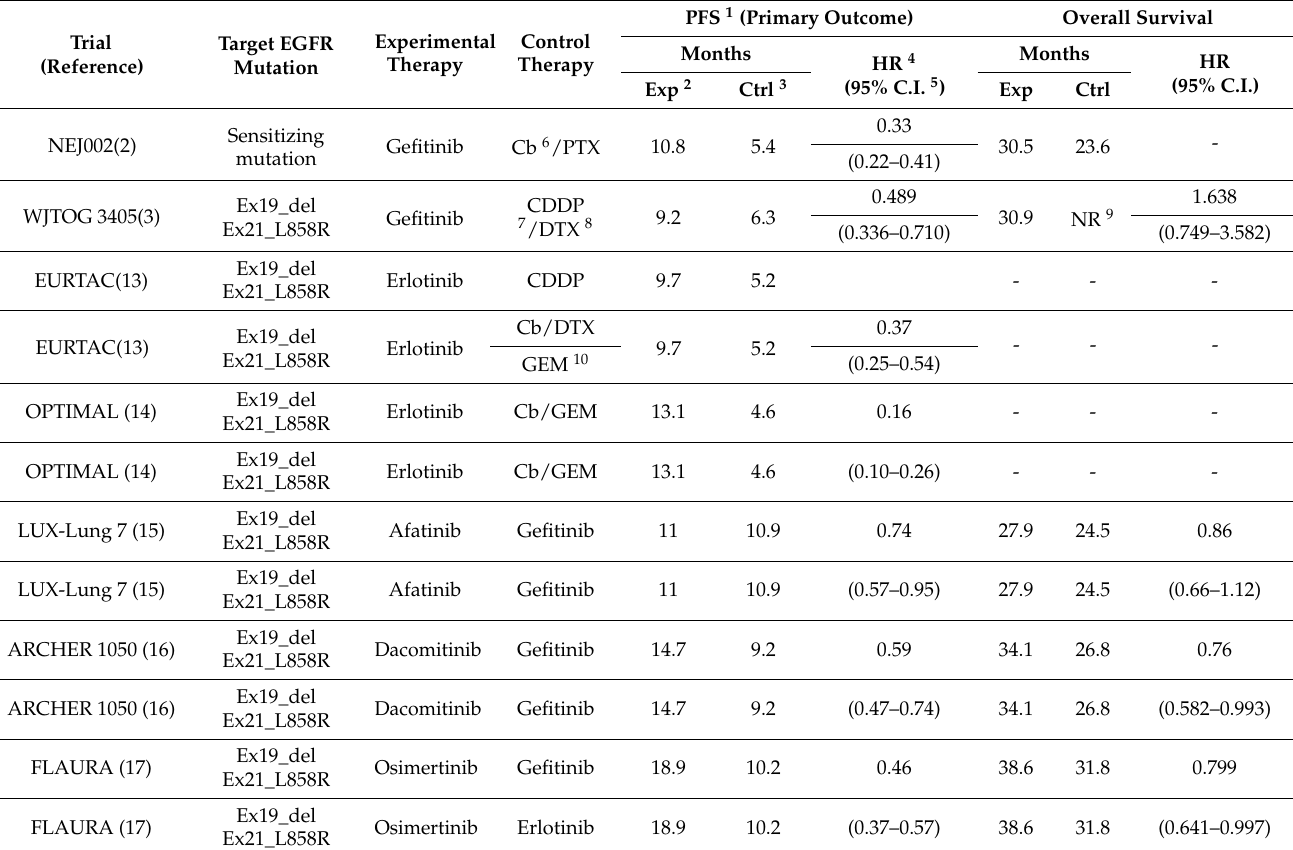
Table 1. List of clinical trials evaluating EGFR-TKI monotherapy in EGFR-mutated lung